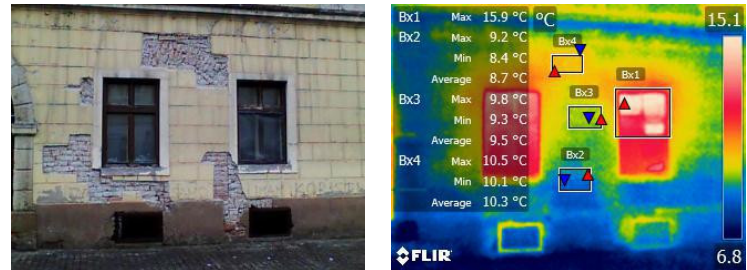
Figure 26. Thermogram of the probing building part of a known wall structure.